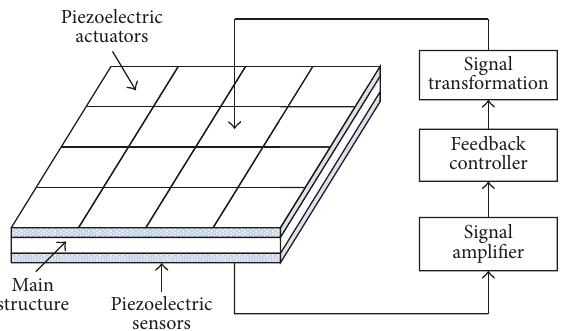
Figure 1: Active static shape control system of a piezoelectric intelligent